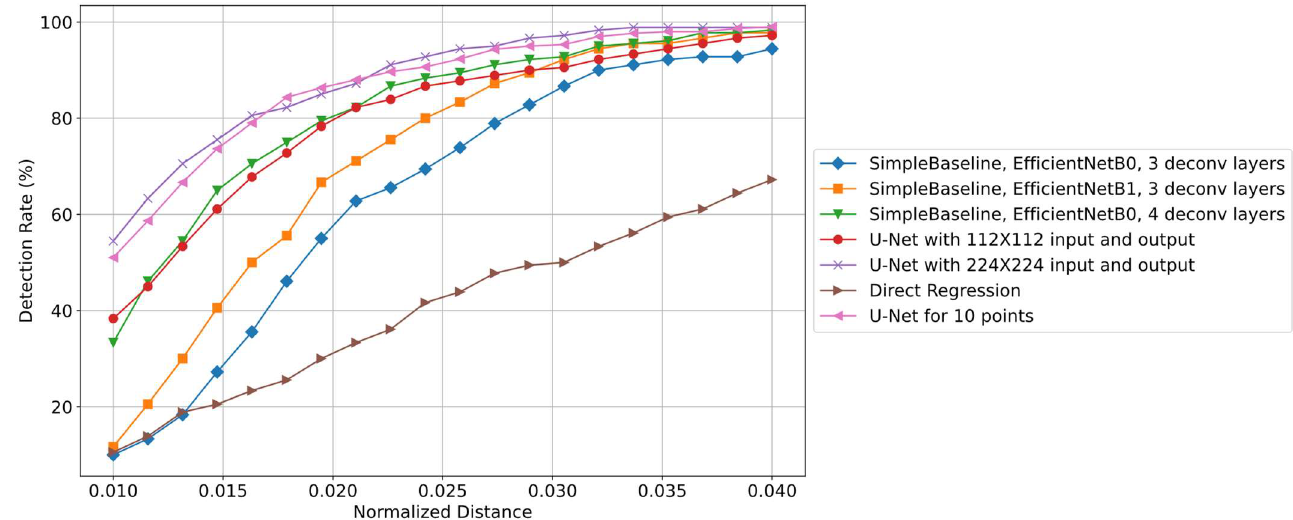
Figure 10. Performance comparison of the explored models using Percentage of Correct Keypoint (PCK) curves. U-Net with and output sizes of 224 × 224 showed the best performance.